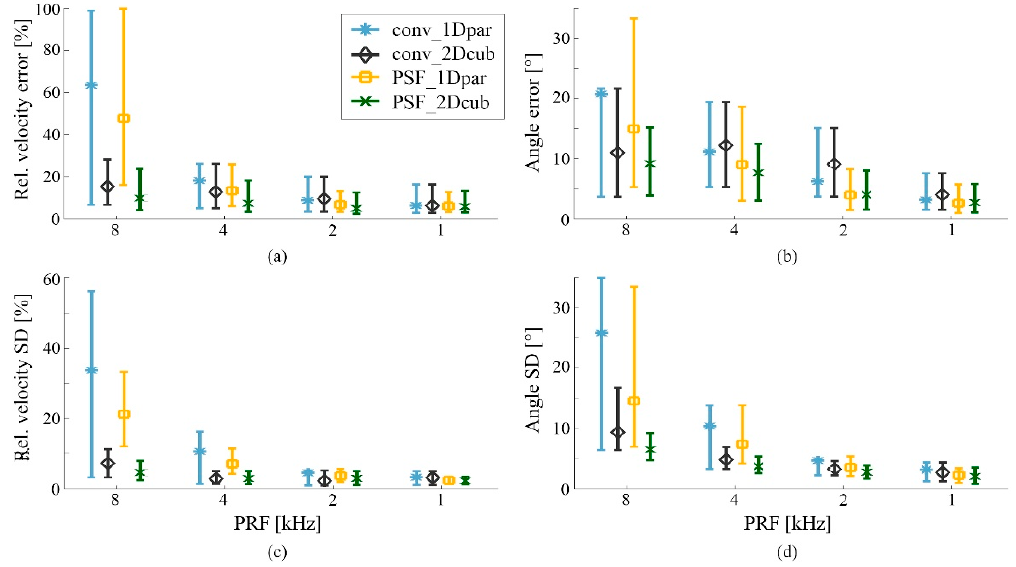
Figure 8. Estimated and ground truth velocity magnitude ( a ) and angle ( b ) obtained from the rotating disk phantom processed as rotational flow. The visualized results are obtained using a PRF of 4 kHz.